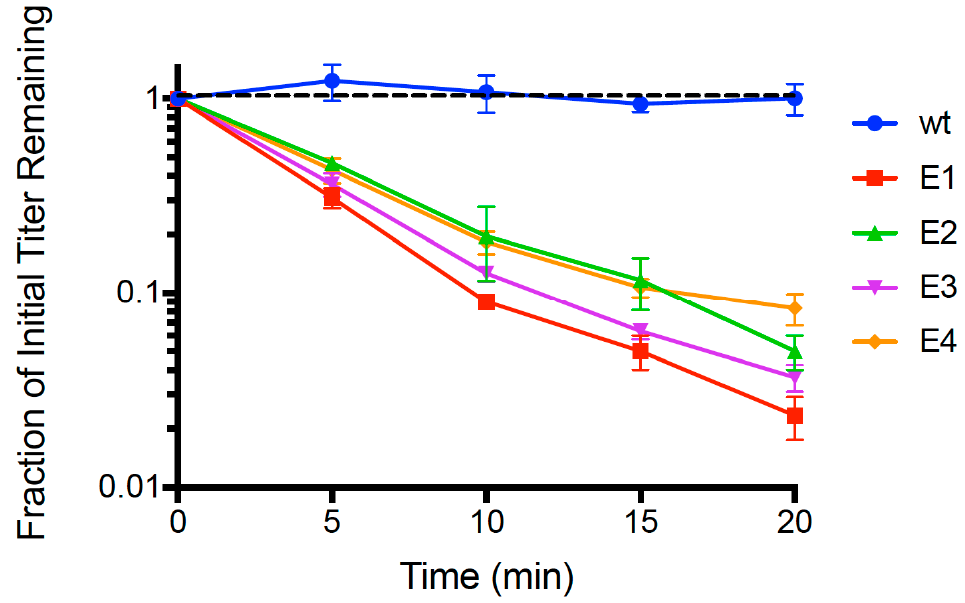
Figure 1. Adsorption of the wt ancestor (phage PP01) and each evolved phage population on dead E. coli O157:H7 cells (MOI = 0.01). Error bars represent 1 standard deviation ( n = 3); error bars too small to be seen are omitted from the graph.